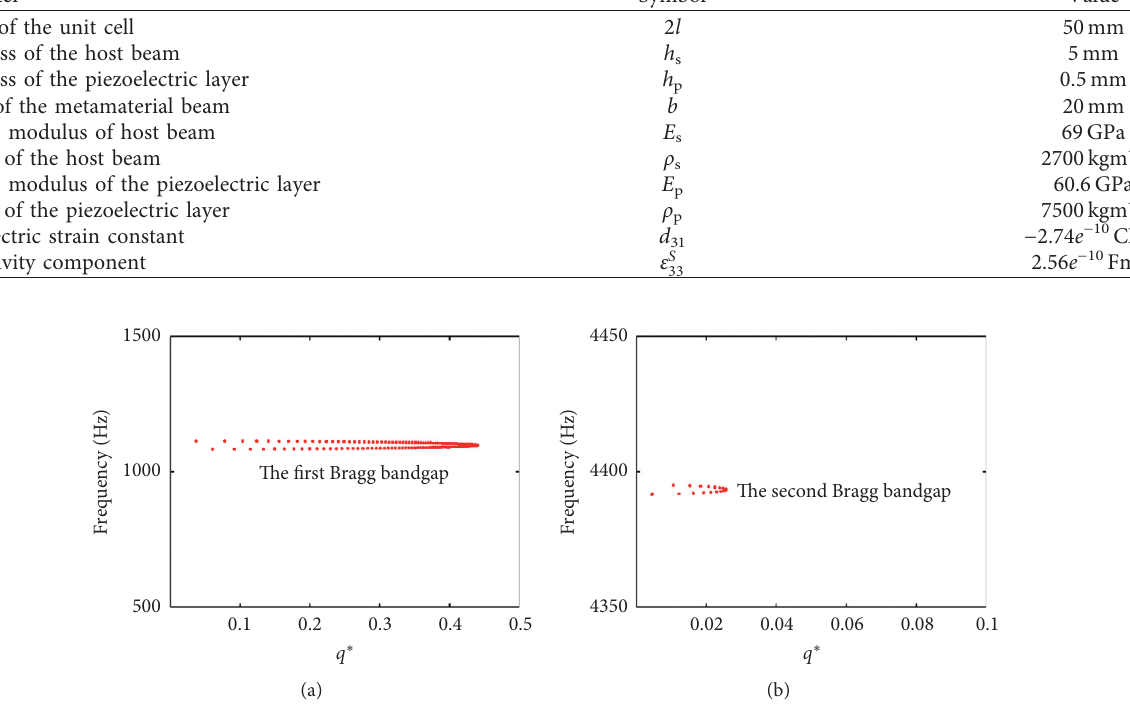
Figure 2: The band structure of the electromechanical metamaterial beam with R (b) the second Bragg